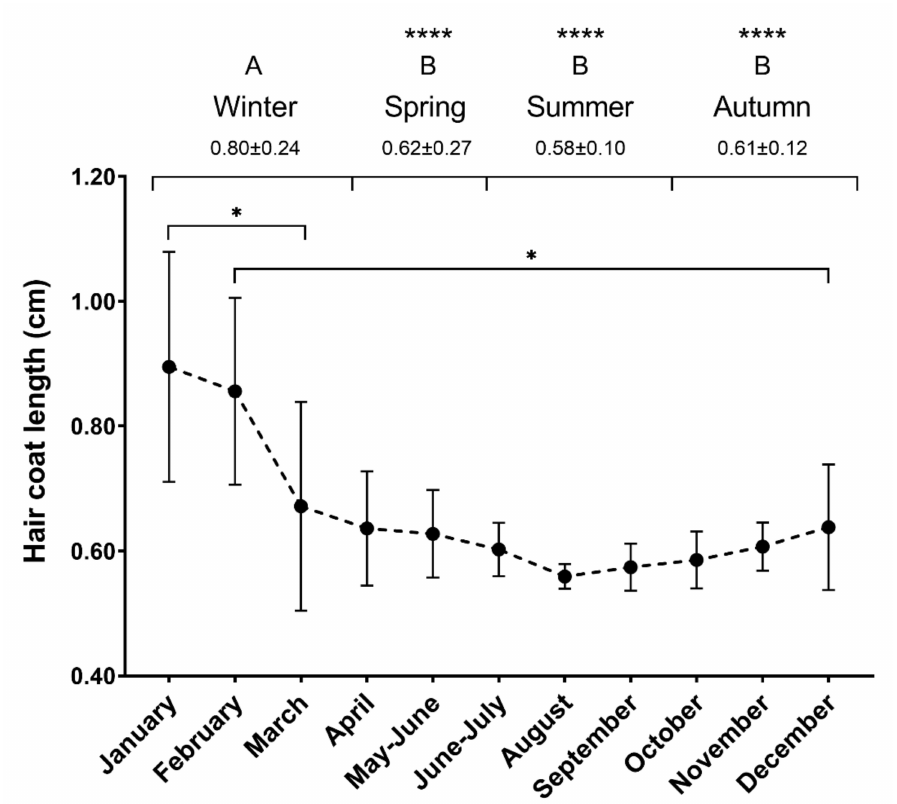
Figure 3. Hair growth rates over a year. Hair growth (cm) for each month and season in the horses included in the study ( n = 5). Di ff erent uppercase letters represent significant di ff erences between seasons. Di ff erent lowercase letters represent significant di ff erences between months (* p < 0.05, **** p < 0.0001). Mean ±